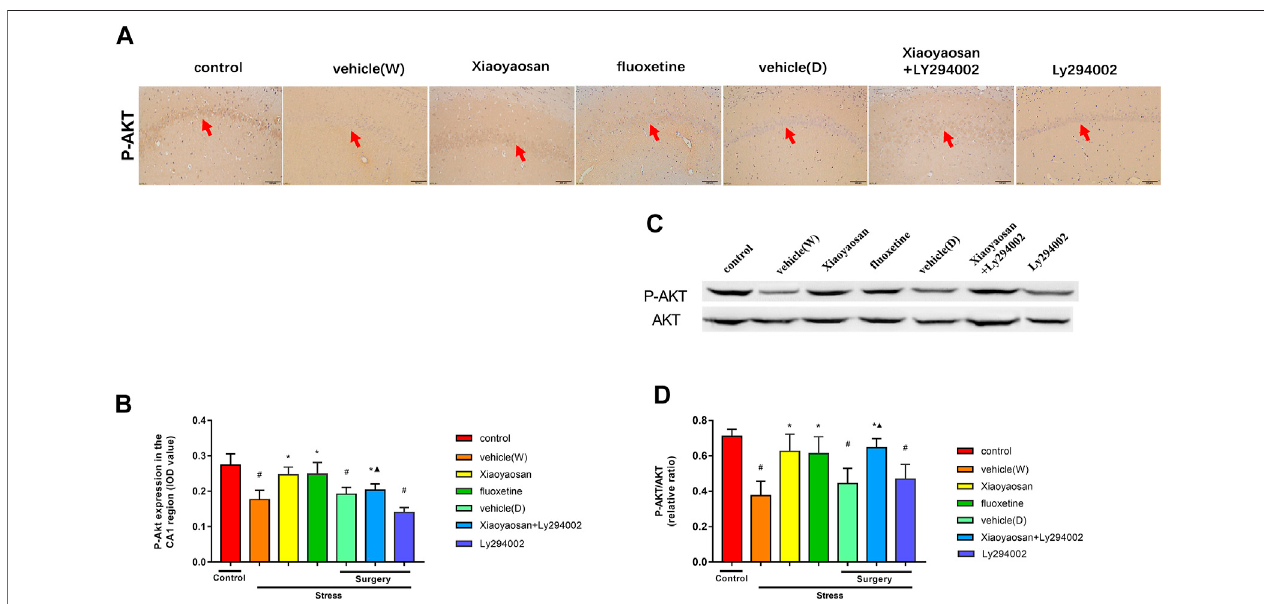
FIGURE8| Xiaoyaosanelevatestheexpression ofP-AKT/AKTinthehippocampal CA1 regionofCUMSratsP-AKT/AKTinthehippocampalCA1 regionofCUMS rats (A) Representativemicrographsofimmunohistochemicalstaining(sectionswerecounterstainedwithhematoxylin;originalmagni fifi cation, × 200)and (B) quantitative analysis showing the expression of P-AKT in the hippocampal CA1 region (C) . Representative images and western blot analysis (D) of western blot assay showing the relative expression ratio of P-AKT/AKT in the hippocampal CA1 region. All data are expressed as the mean ± SD. # p < 0.05 compared to the control group; * p < 0.05, compared to the vehicle (W) group; ▲ p < 0.05 compared to the Ly294002 group, n (cid:2) 6.